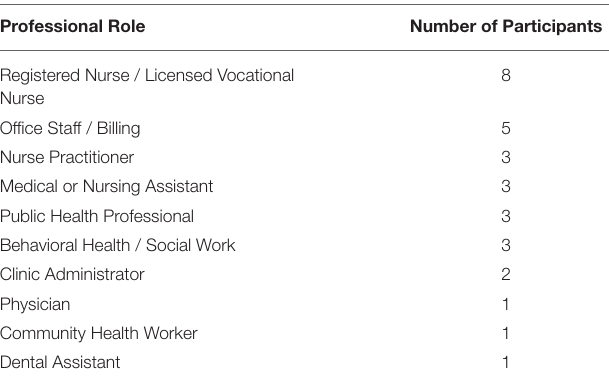
TABLE 1 | Professional role of listening session